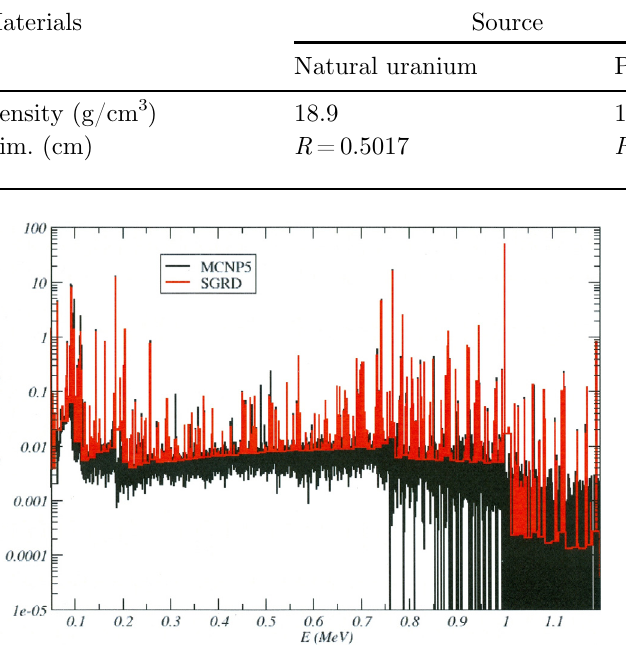
Fig. 7. Scintillation NaI detector response functions. The different colors correspond to different incident energies of the gamma particles entering the detector.